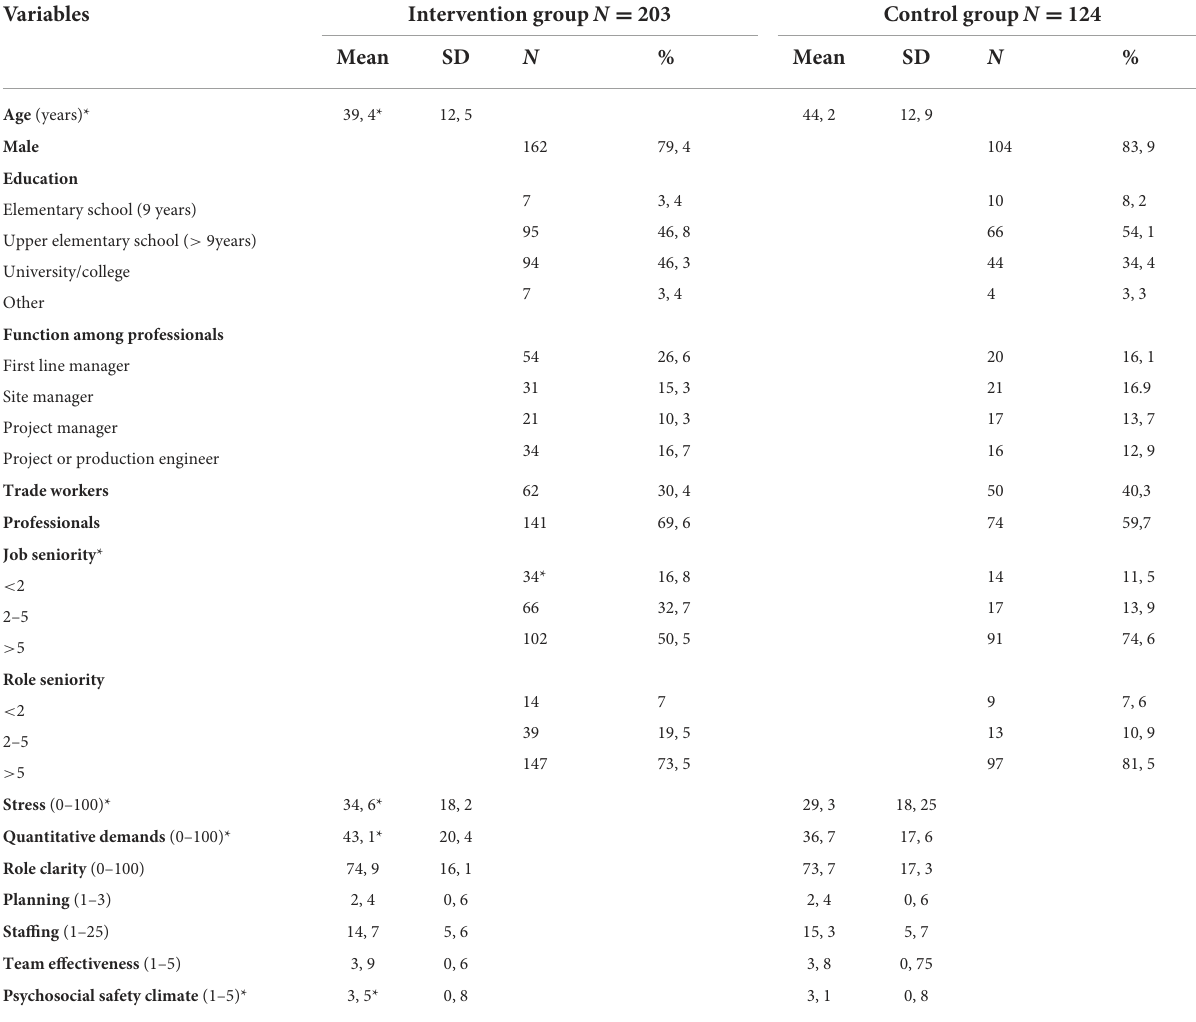
TABLE 1 Outcome and demographical characteristics at baseline of the workers in the intervention and control group. Variables Intervention group N =